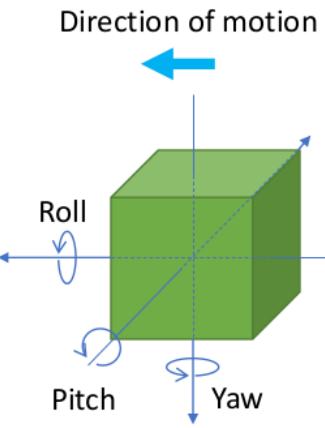
Figure 6. Euler angles defined for the